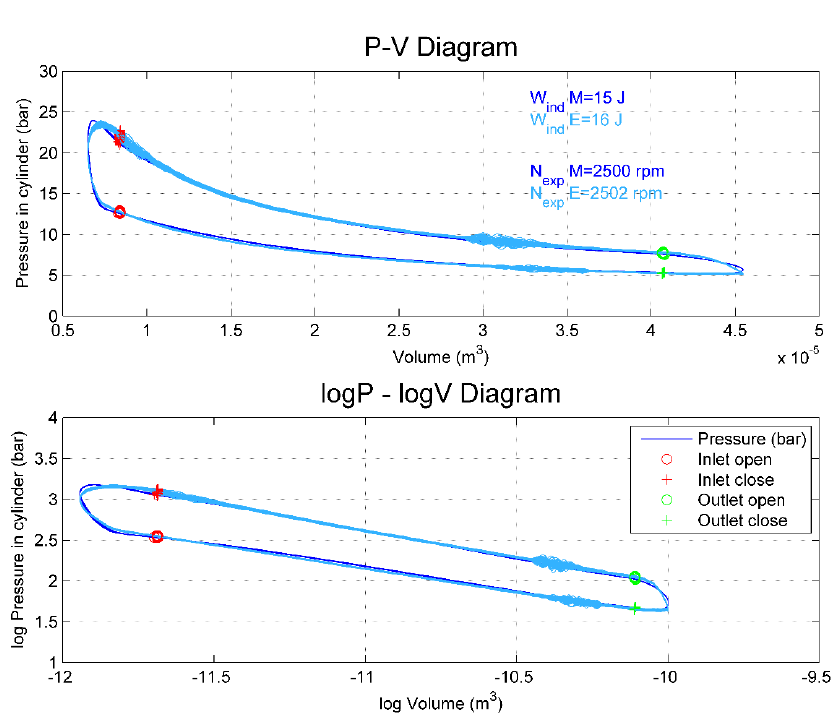
Energies 2016 , 9 , 279